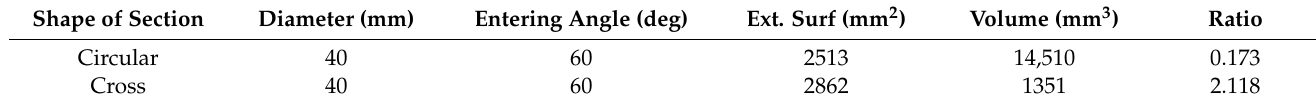
Table 2. Comparison of the lateral surface areas and volumes for the conical and cross-shaped nails.